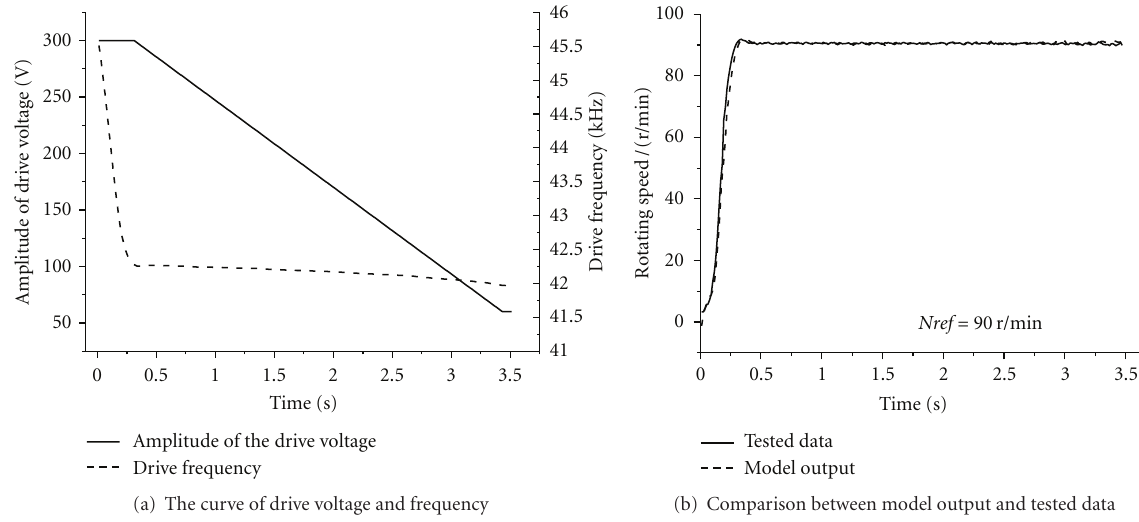
Figure 11: Step response comparison between model output and tested data ( Nre f = 90 r/min, no